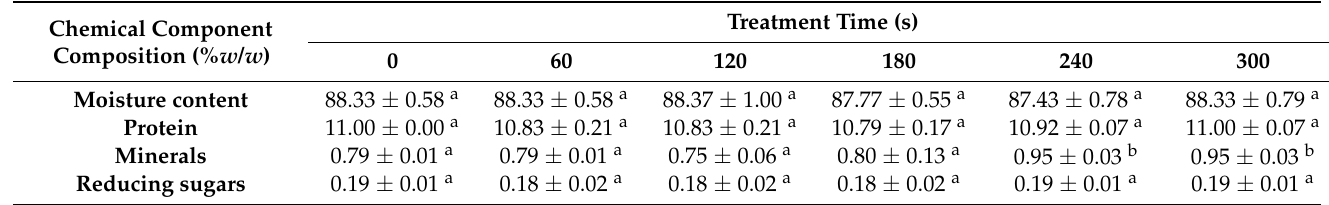
Table 1. Chemical components composition of HVCP treated